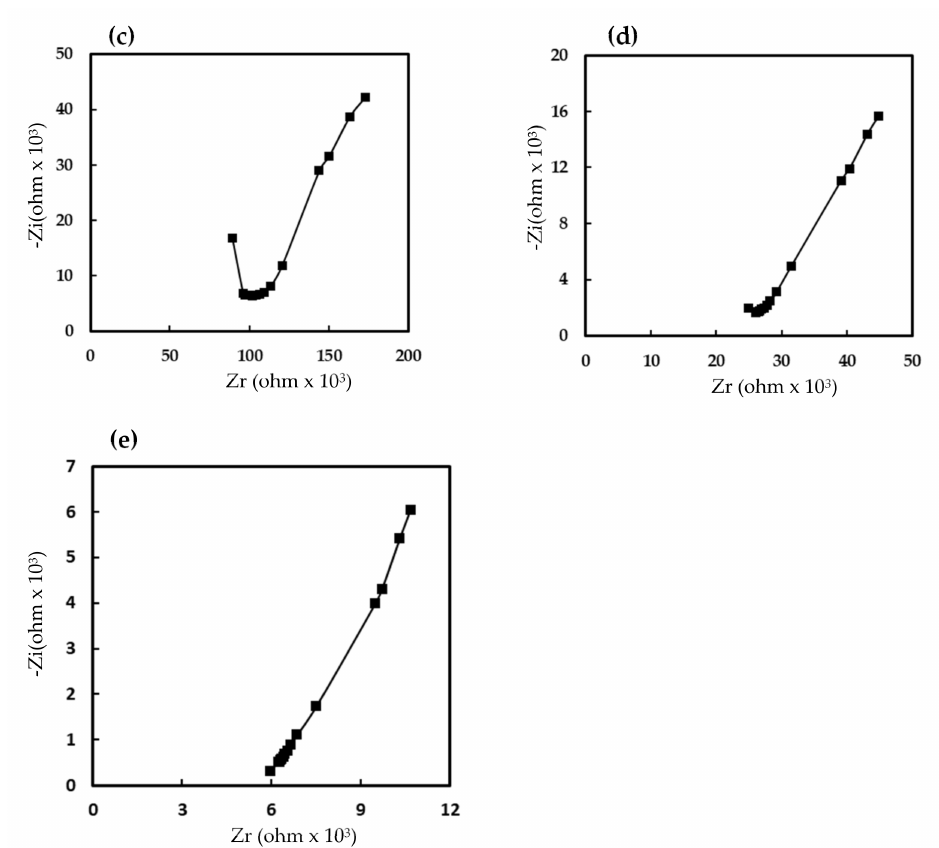
Figure 6. Complex impedance plots of humidity sensor based on 7 wt% EuCl 2 /Eu 2 O 3 blend film at ( a ) 20% RH, ( b ) 40% RH, ( c ) 50% RH, ( d ) 60% RH and ( e ) 80% RH. Measurements were made at frequency ranging from 50 to 100,000 Hz, RH ranging from 20 to 80% RH, at 1 V AC voltage and at 25 ◦